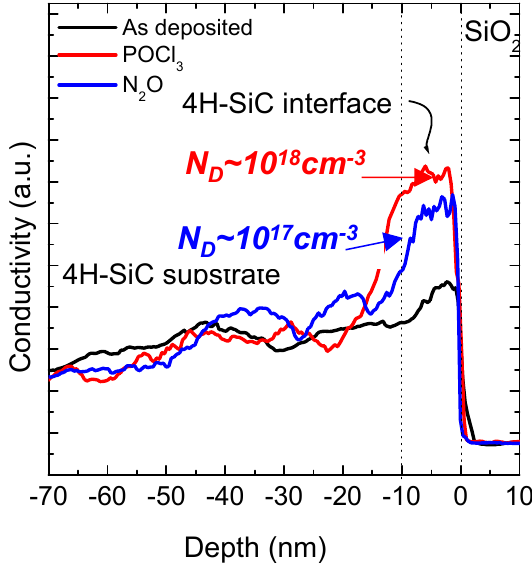
Figure7. SSRM(scanningspreadingresistancemicroscopy)carrierconcentrationacrosstheSiO 2 / 4H-SiC Figure 7. SSRM (scanning spreading resistance microscopy) carrier concentration across the interfaces on the as deposited (black line) and N 2 O annealed (blue line) SiO 2 /4H-SiC interfaces on the as deposited (black line) and N 2 O annealed (blue line) samples.